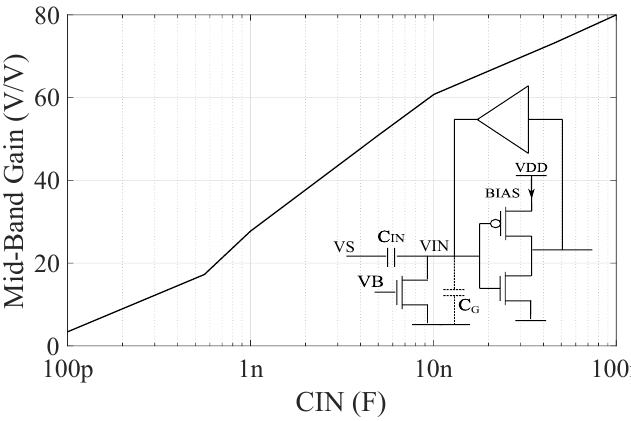
Figure 24. Mid-Band Gain for different value of C IN .